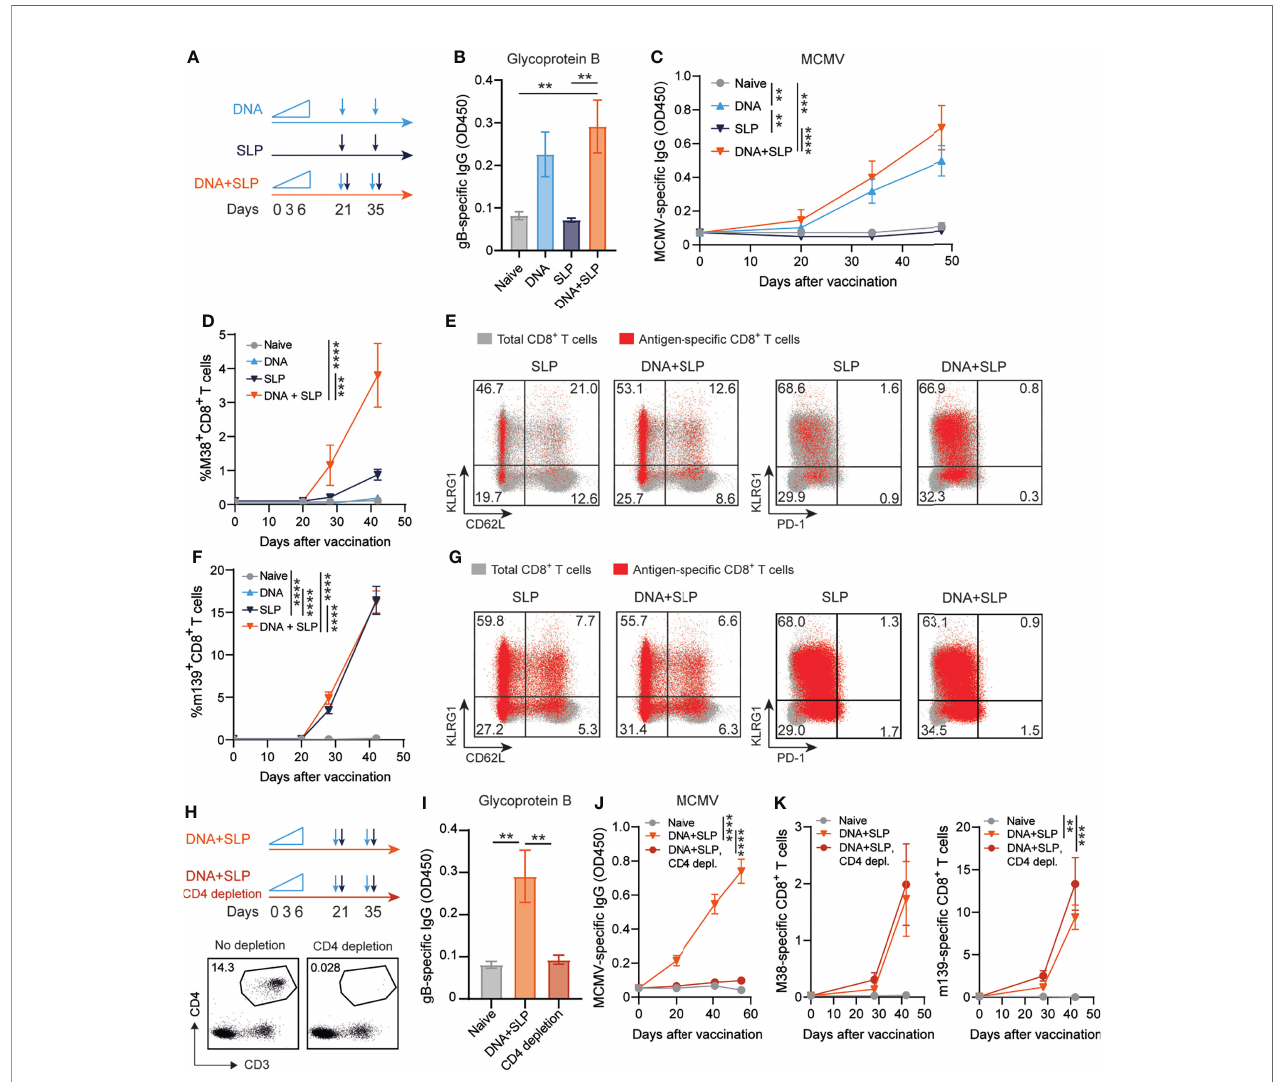
FIGURE 3 | Combining the sgB DNA vaccine with synthetic long peptide vaccines enhances antibody and CD8 + T cell responses. (A) Vaccination schedule for mice vaccinated with the sgB DNA vaccine and/or the SLP vaccine. The sgB DNA vaccine was intradermally with an increasing dose prime schedule (10 µg on day 0, 20 µg on day 3 and 30 µg on day 6) followed by two booster immunizations with 60 µg. The SLP vaccine (synthetic long peptides containing the M38 and m139 class I epitopes, adjuvanted with CpG) was provided subcutaneously on day 21 and day 35. (B) Glycoprotein B-speci fi c IgG response on day 72 after vaccination in blood. Data shown are mean values ± SEM (n=8). One-way ANOVA was used for statistical analysis. (C) Kinetics of the MCMV-speci fi c IgG response in serum over time. Data shown are mean values ± SEM (n=8). One-way ANOVA on day 48 was used for statistical analysis. (D, F) Kinetic analysis of the M38- (D) and m139- speci fi c (F) CD8 + T cell response. Data shown are mean values ± SEM (n=8). One-way ANOVA on day 48 was used for statistical analysis. (E, F) Representative fl ow cytometry plots showing the KLRG1 vs CD62L or KLRG1 vs PD-1 cell-surface expression on the total CD8 + T cells (gray) and M38- (E) and m139-speci fi c (G) CD8 + T cells (red) in blood at day 7 post-boost vaccination. Indicated percentages are representative values for each group. Experiments were performed twice with similar outcome. (H) Vaccination schedule for mice vaccinated with the sgB DNA vaccine and the SLP vaccine with and without CD4 + T cell depletion during the vaccination period. The vaccines were administered as described in (A) . The CD4 + T cell depleting antibody was administered s.c. every six days. Representative fl ow cytometry plot showing con fi rmation of CD4 + T cell depletion in blood. (I) Glycoprotein B-speci fi c IgG response on day 72 after vaccination in blood. Data shown are mean values ± SEM (n=9). One-way ANOVA was used for statistical analysis. **P<0.01. (J) Kinetics of the MCMV-speci fi c IgG response in serum over time. Data shown are mean values ± SEM (n=9). One-way ANOVA on day 55 was used for statistical analysis. (K) Kinetic analysis of the M38- and m139-speci fi c CD8 + T cell response. Data shown are mean values ± SEM (n=8). One-way ANOVA on day 42 was used for statistical analysis. **P<0.01, ***P<0.001,